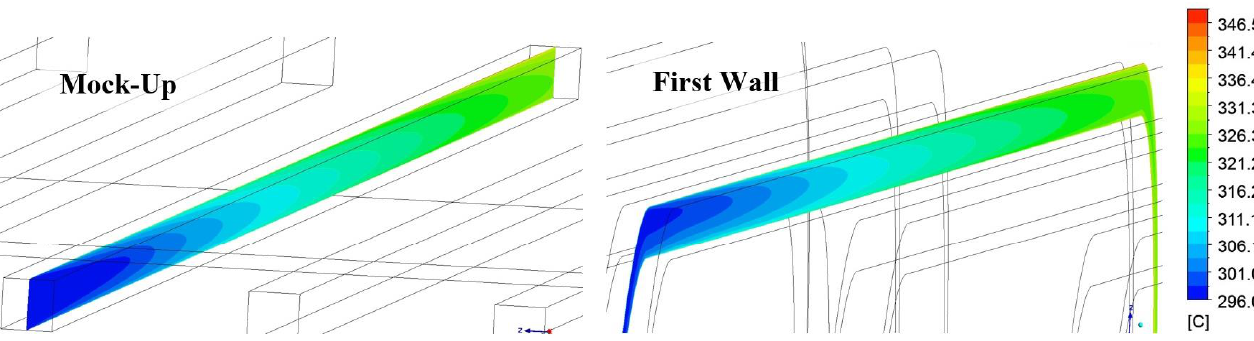
Energies 2023 , 16 , x FOR PEER REVIEW Figure 6. Wall temperature along the channel sides for the FW and the MU. Figure 6. Wall temperature along the channel sides for the FW and the MU.